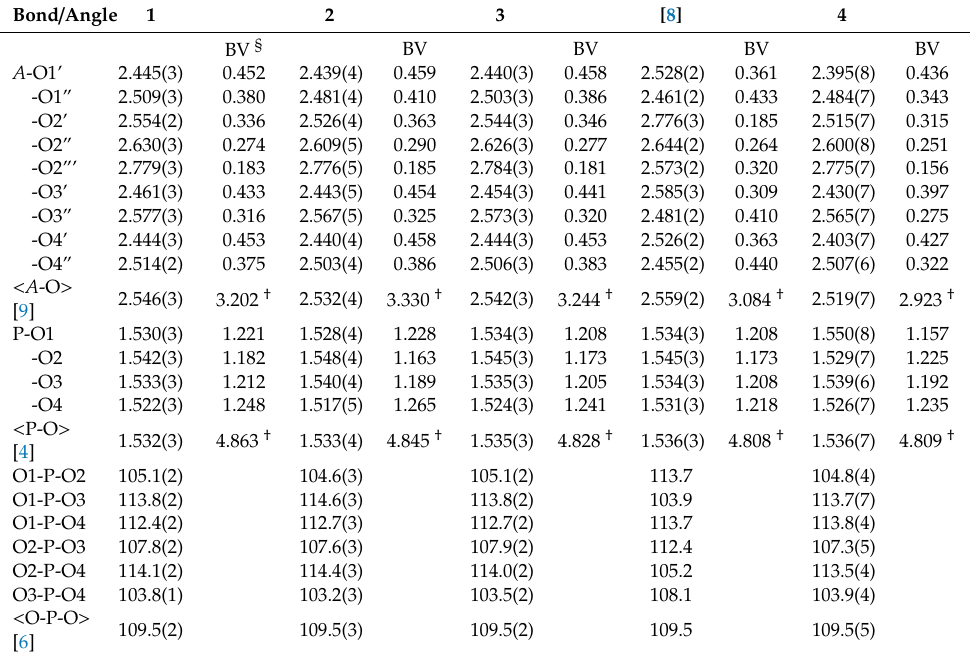
Table 5. Bond distances (Å), angles ( ◦ ), and -bond valences for the four monazite samples used in this